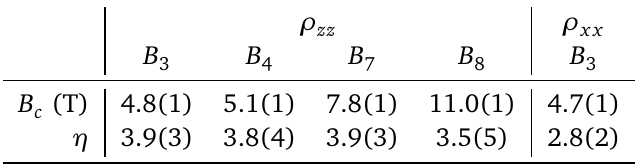
Table 1: Characteristics of the LTs: magnetic field values B in Figs. 2 and 4 as well as the g -factor anisotropy η extracted from fits to B shown in Fig. 3 for ρ